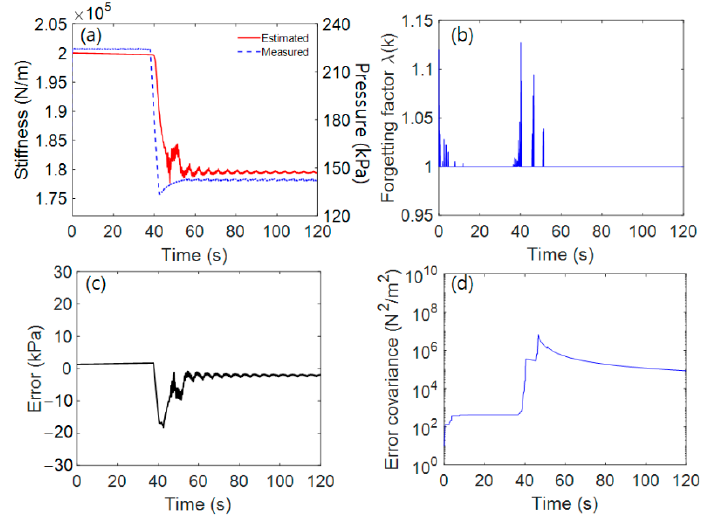
Figure 12. Experimental results of tire stiffness estimation; ( a ) response of time-varying tire stiffness to slew rate limited input (pressure drop), ( b ) time evolution of the forgetting factor, ( c ) estimation error and ( d ) convergence history of the error covariance.